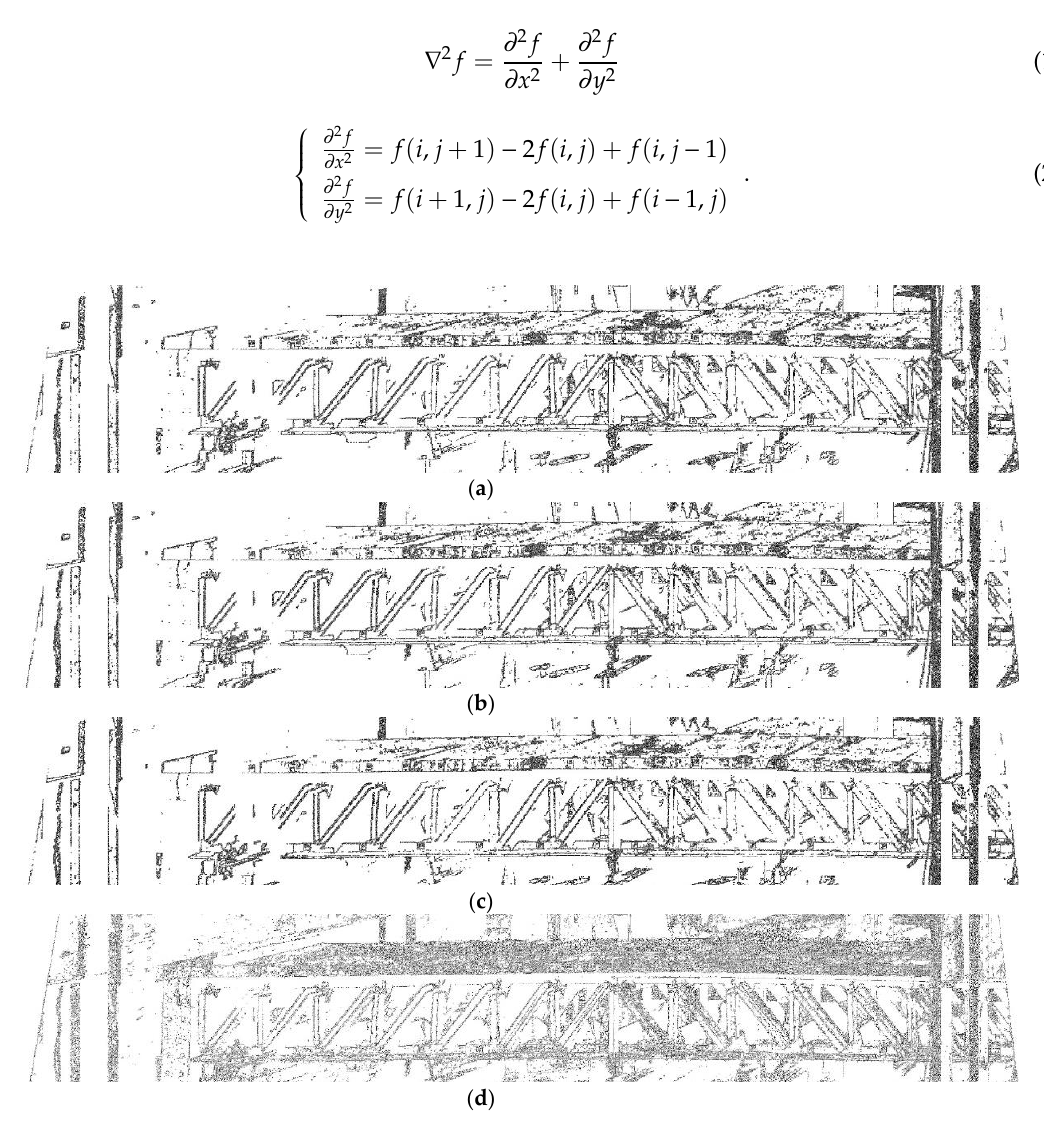
Figure 9. The applied five kinds of edge detection operators; ( a ) Sobel operator edge detection; ( b ) Prewitt operator edge detection; ( c ) Roberts operator edge detection; ( d ) log operator edge detection. Based on the second-order di ff erential of the image, the extreme points can be generated at the abrupt position of the gray value. According to these extreme points, the edge of the structure can be